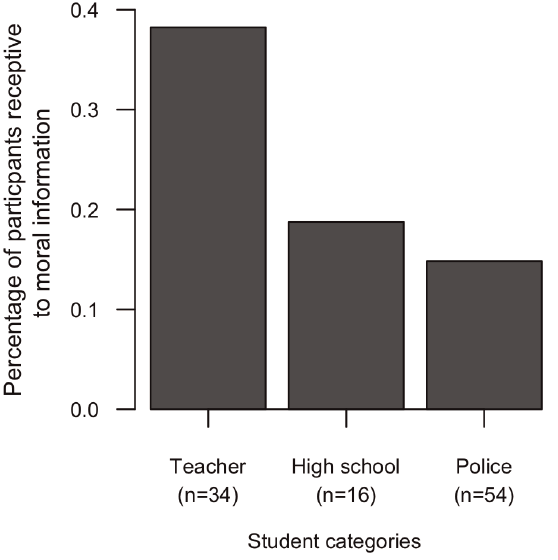
Figure 2. Proportion of participants exposed to moral in- formation reporting that moral information influenced their decision. Overall proportions differed significantly among socio- professional categories (two-sided Fisher’s exact test: p=0.048).